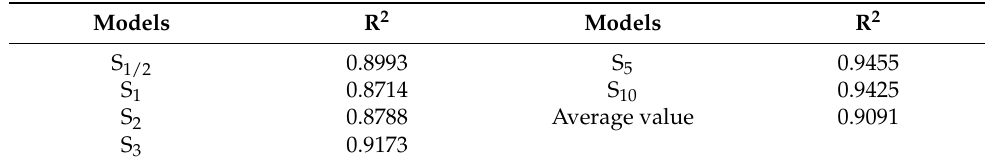
Table 4. Accuracy tests of response surface